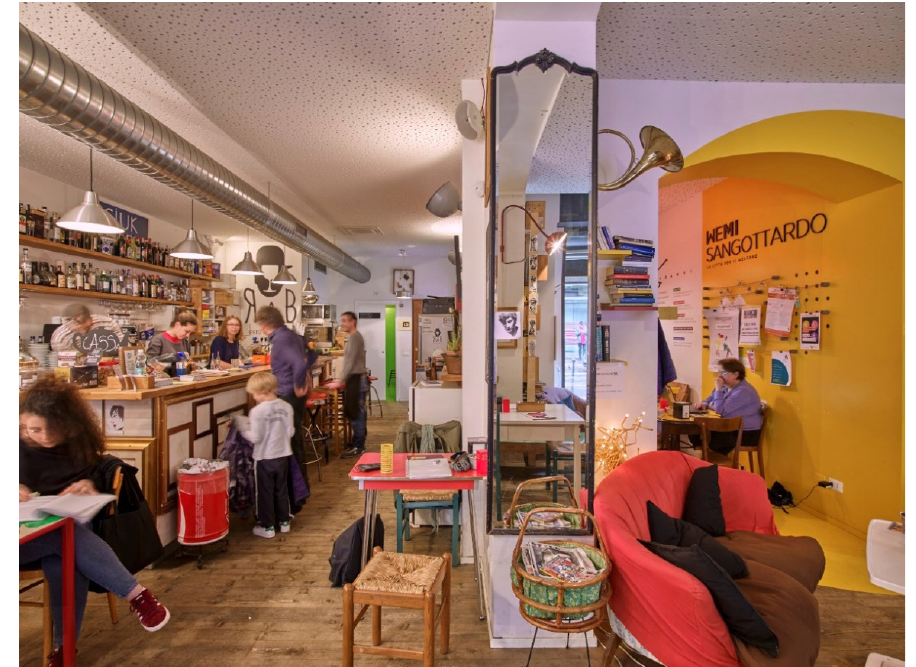
Figure 3. RAB–WeMi San Gottardo, view of the interiors. Source: Courtesy of Giovanni Hänninen. meetings over the phone or in person, the site visit allowed us to appreciate how the location of the space was particularly important. Open to all citizens, it required walking through the entire length of the struc‐ ture in order to reach it; this contributed to bringing the city inside the structure and letting citizens get in touch with some of the activities of the residents (Figure 5).